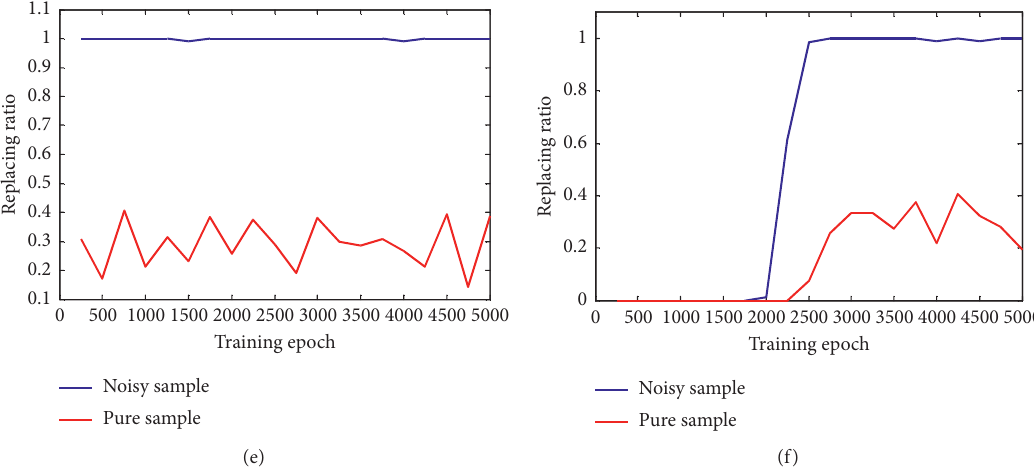
Figure 9: Train losses, sample loss distributions, and label replacing ratios in Part 1 and Part 2. (a, e) Part 1, (b, f) Part 2, (c) No. 250 epoch of Part 1, and (d) No. 250 epoch of Part